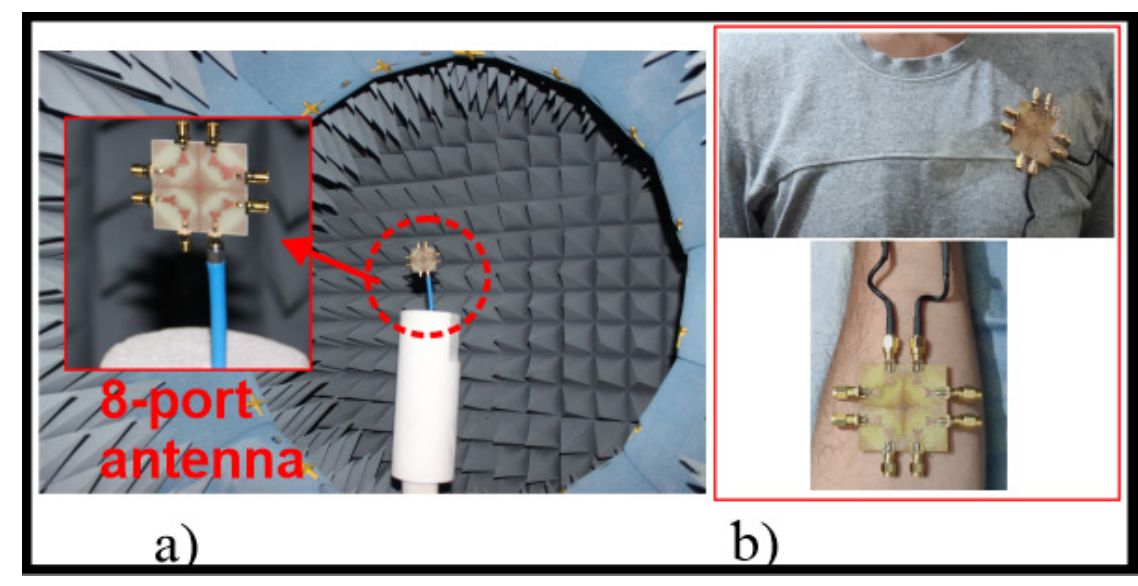
Figure 4. Measurements of the proposed MIMO antenna array: ( a ) free space; ( b ) on-body.